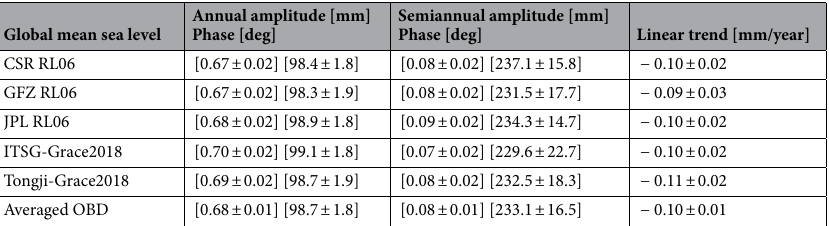
Table 1. Amplitudes of annual and semi-annual components and linear trends of OBD derived from five GRACE solutions. The uncertainty represents the least-squares fitting error (1 sigma for amplitudes and phases and 2 sigmas for